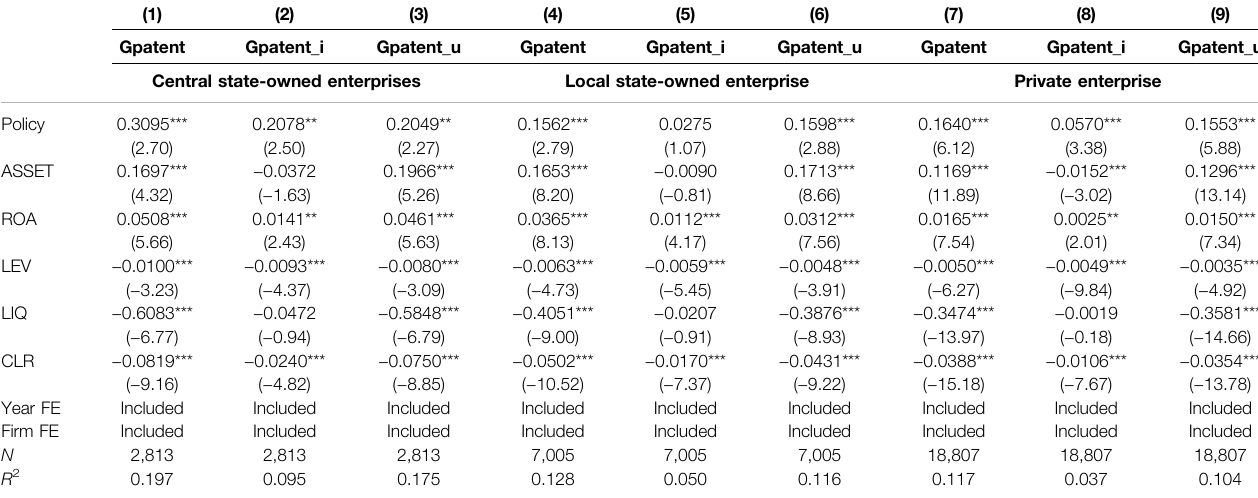
TABLE 5 | Results of the heterogeneity of enterprise